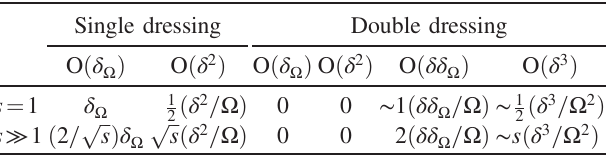
TABLE I. Leading residual sensitivities of the qubit transition frequency: first order in the drive noise ( δ Ω ), second and third order in the inhomogeneous shift ( δ 2 , δ 3 ), and the cross term ( δ Ω · δ ). For the double-dressing scheme, exact numerical factors depend on the experimental realization, including the phase between the two fields. These factors and their exact derivation are given in Appendix